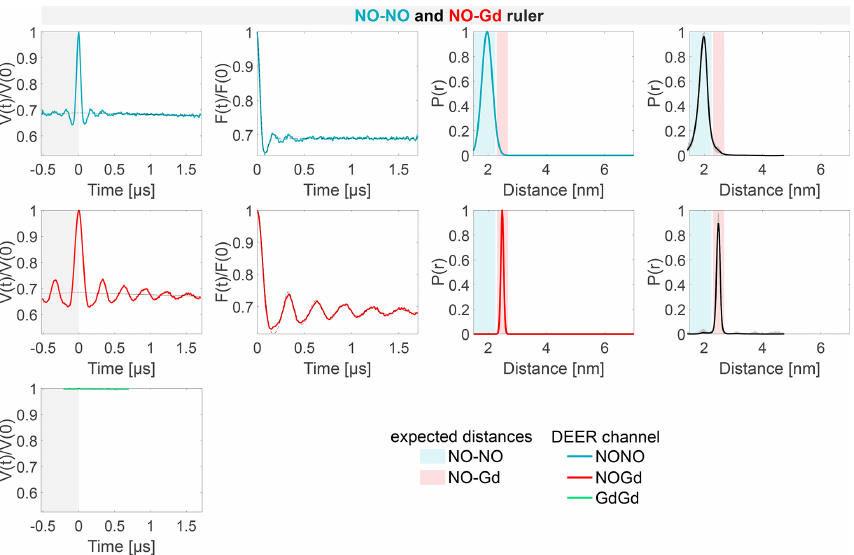
Figure 5. Sample containing the NO–NO and the NO–Gd rulers mixed in a 1 : 1 molar ratio. The legend is the same as in Fig. 4. No crosstalk signals are detected in this